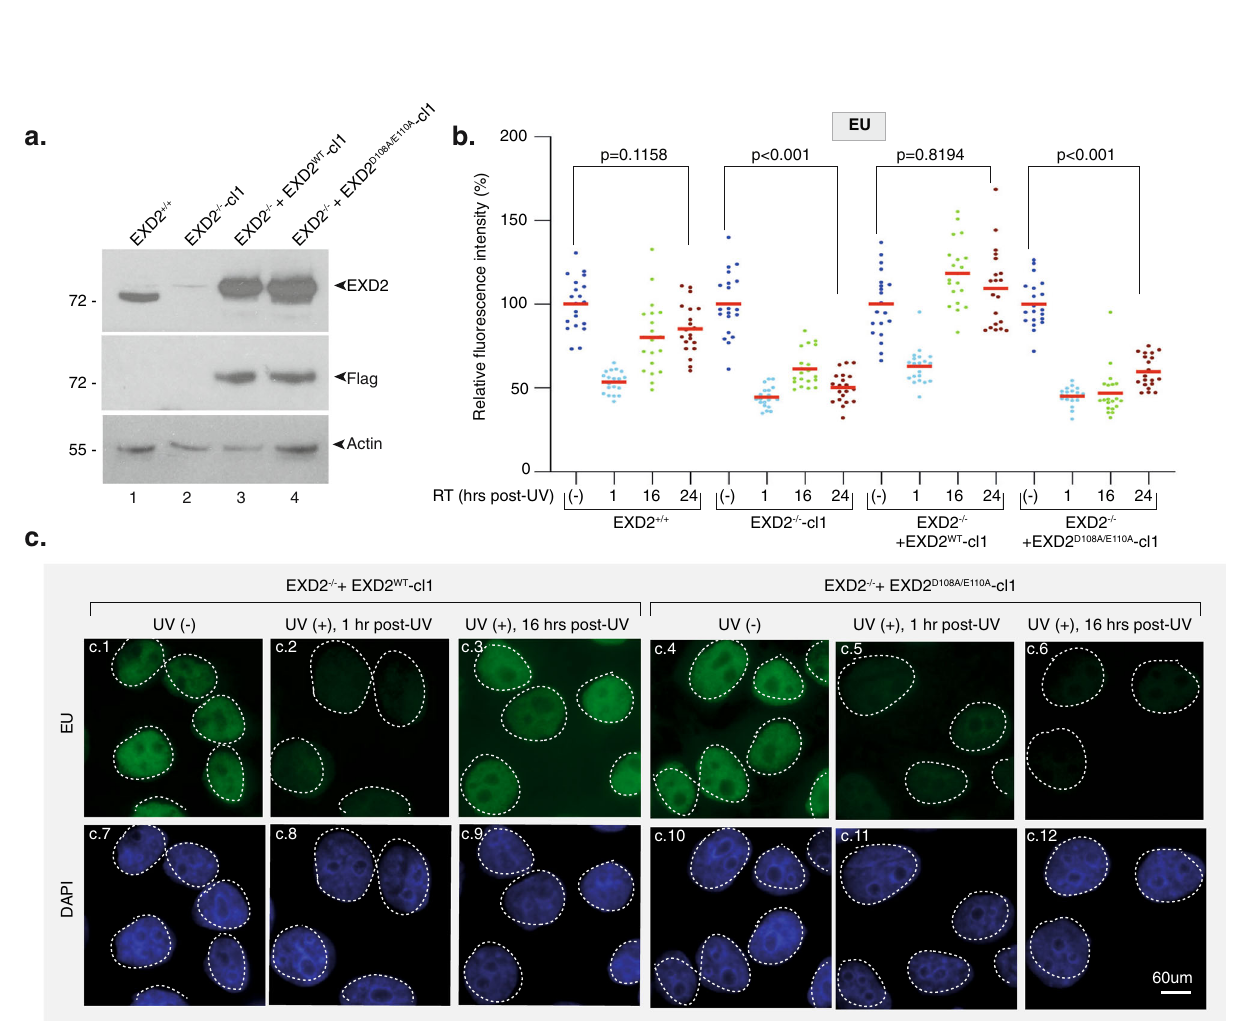
Fig. 2 | Knockdown of EXD2 nuclease activity impairs global RRS. a Protein lysates from EXD2 +/+ , EXD2 − / − -cl1, EXD2 − / − +EXD2 WT -cl1 and EXD2 − / − +EXD2 D108A/E110A - cl1 cells were immuno-blotted for proteins as indicated. Molecular mass of the proteins is indicated (kDa). Source data are provided as a Source Data fi le. b Cells were mock- or UV-irradiated (15J/m 2 ) and mRNA was labeled with EU at the indi- cated time points post-UV. EU signal was quanti fi ed by ImageJ and relative inte- grateddensities,normalizedtomock-treatedlevelsetto100%,arereportedonthe